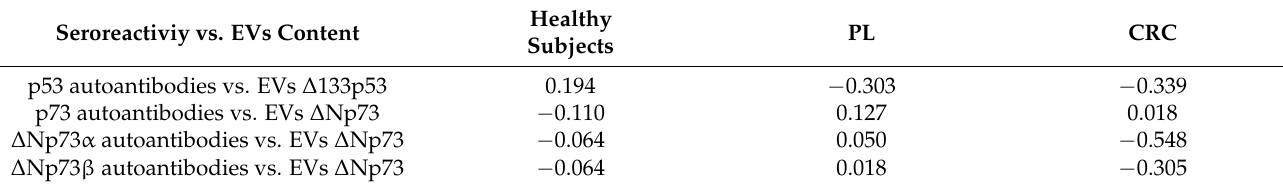
Table 2. Correlations between the seroreactivity of different variants of the p53 family (p53, p73, ∆ Np73 α , and ∆ Np73 β ) and ∆ Np73 and ∆ 133p53 EV content. The Spearman correlation coefficient (r) is shown in the table. Healthy PL CRC Seroreactiviy vs. EVs Content Subjects p53 autoantibodies vs. EVs ∆ 133p53 0.194 − 0.303 − 0.339 p73 autoantibodies vs. EVs ∆ Np73 −